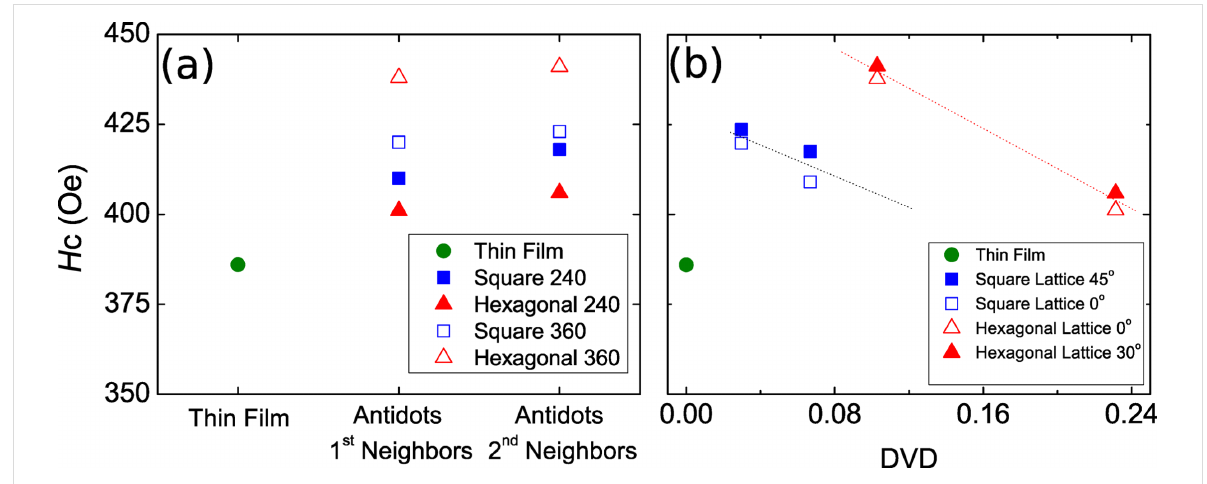
Figure 5: (a) Coercivity of the initial thin film and of the square (blue squares) and the hexagonal (red triangles) arrays, considering two different lattice parameters, and applying the external magnetic field along the first and second neighbors directions. (b) Coercivity as a function of the defect volume density (DVD).